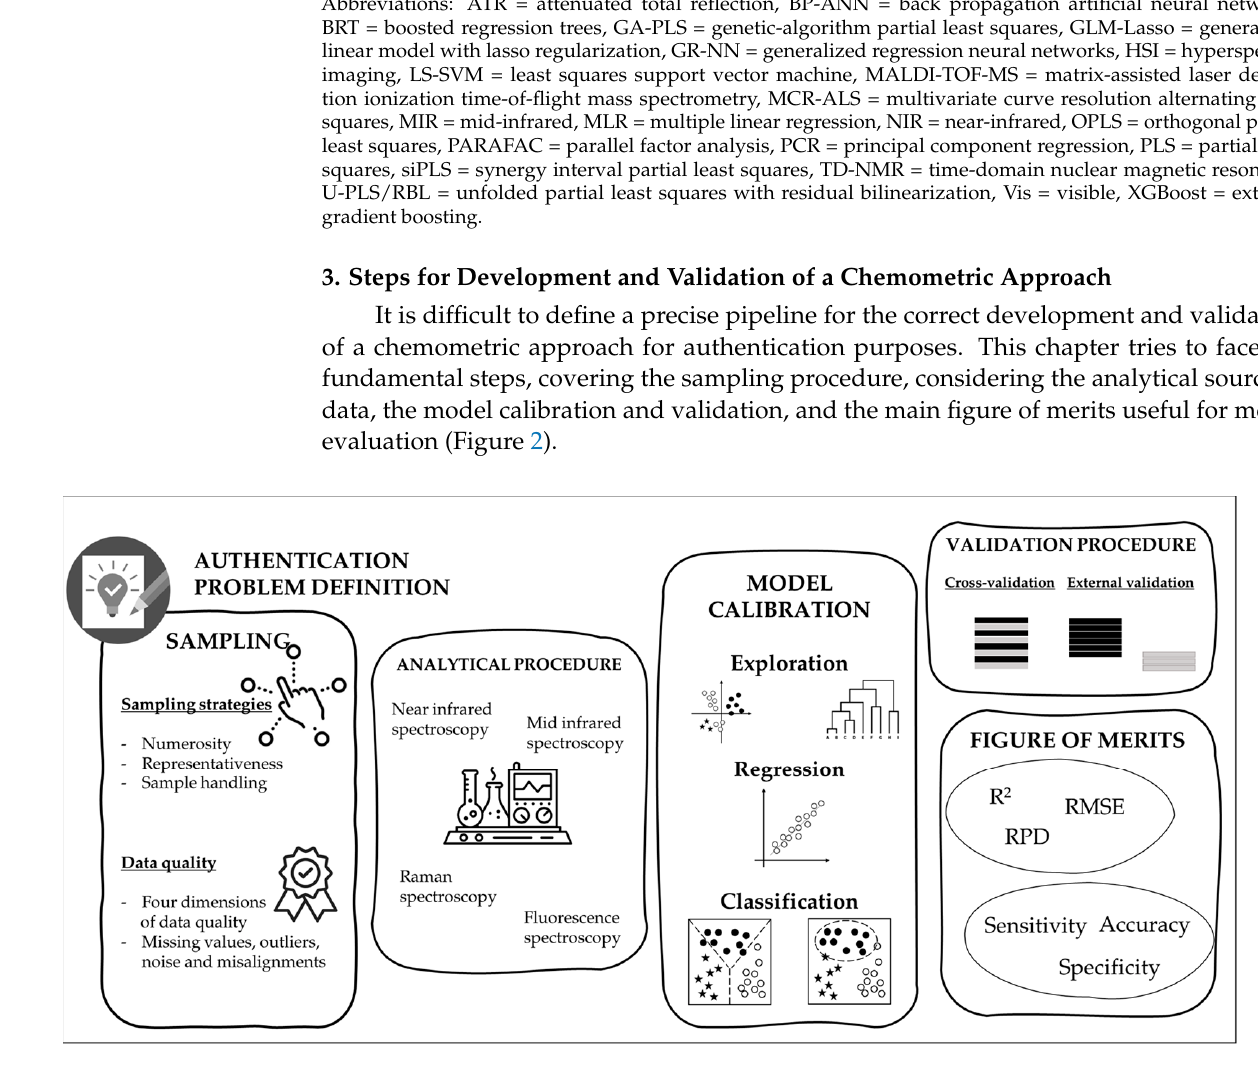
Figure 2. Schematic representation of the main steps useful to develop and validate a chemometric approach.